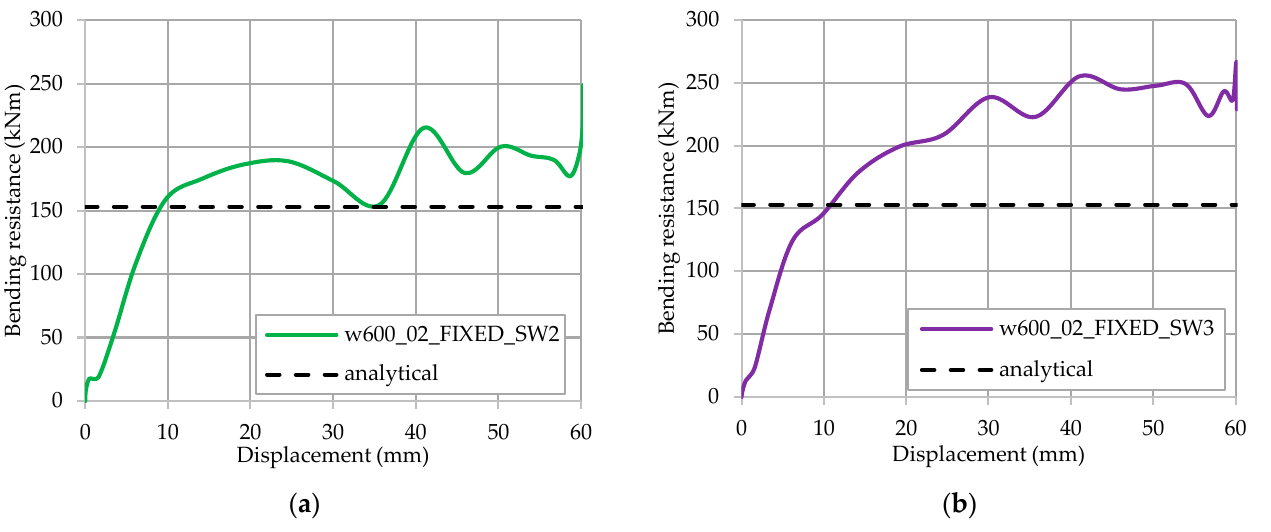
Figure 23. Bending resistance of the fixed beam for shear connectors spaced at 600 mm: ( a ) SW2; ( b ) SW3.